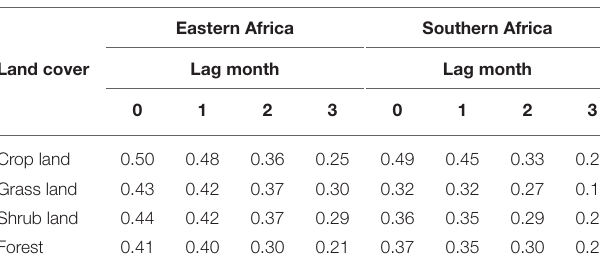
TABLE 2 | Correlation coefficients computed between root-zone soil moisture and NDVI anomalies for different land cover types over Eastern and Southern